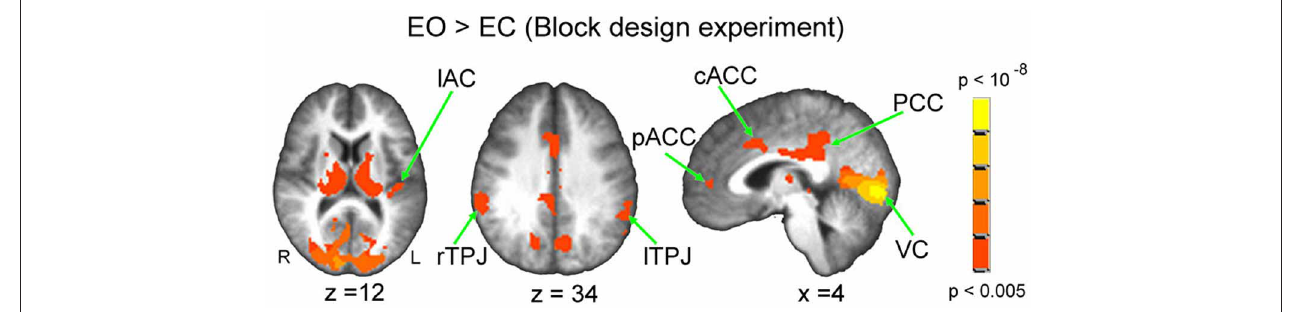
FIGURE 2 | Activated brain areas based on the contrast EO > EC from the block-design experiment. The results were significant at p < 0 . 05 (FWE corrected). For display purposes, the results are exhibited with a threshold of p < 0 . 005 uncorrected.